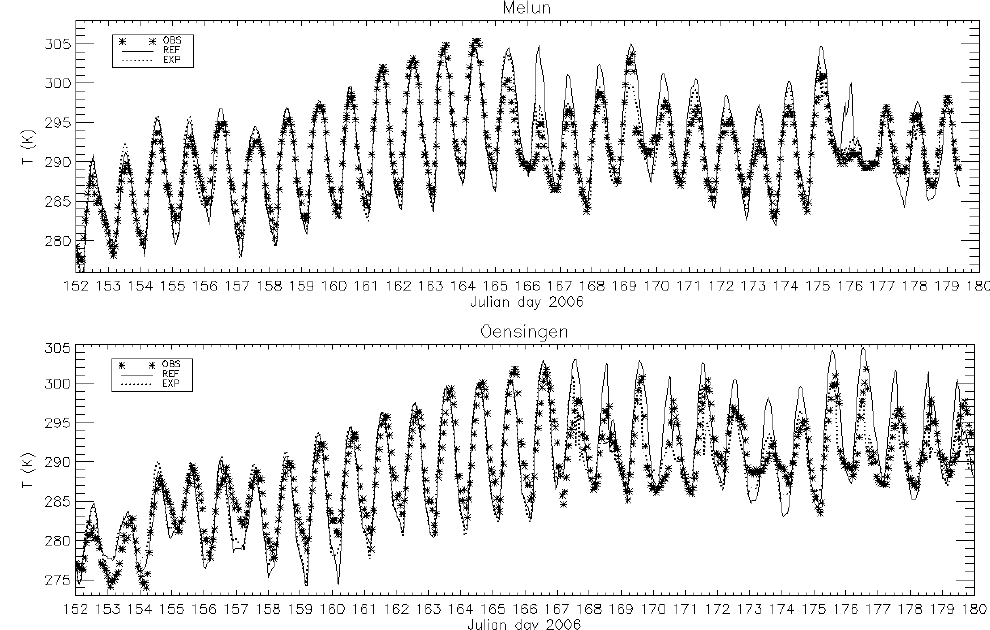
Figure 3: 2 m air temperature at Melun (upper panel) and Oensingen (lower panel) for June 4